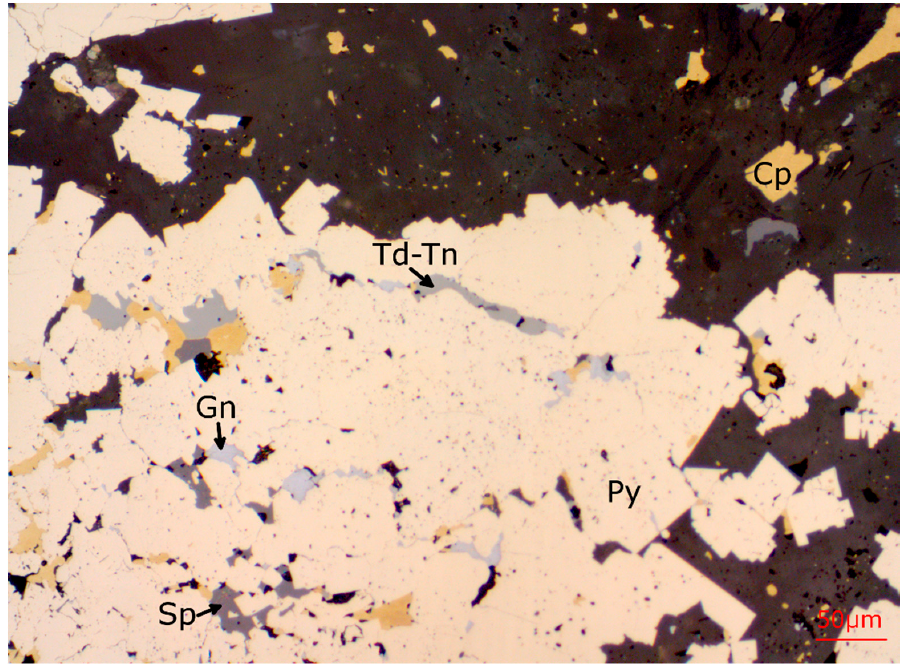
Figure 6. Reflected light photomicrograph from the L4-7-105.7 polished thin section. Tetrahedrite grains are commonly in contact with Cp, Sp, and Gn at grain boundaries, and occur frequently as veinlets or along grain boundaries within pyrite. Chalcopyrite has the same grain size distribution in gangue-rich areas as Py-rich areas, whereas this is not the same for Sp and Gn.